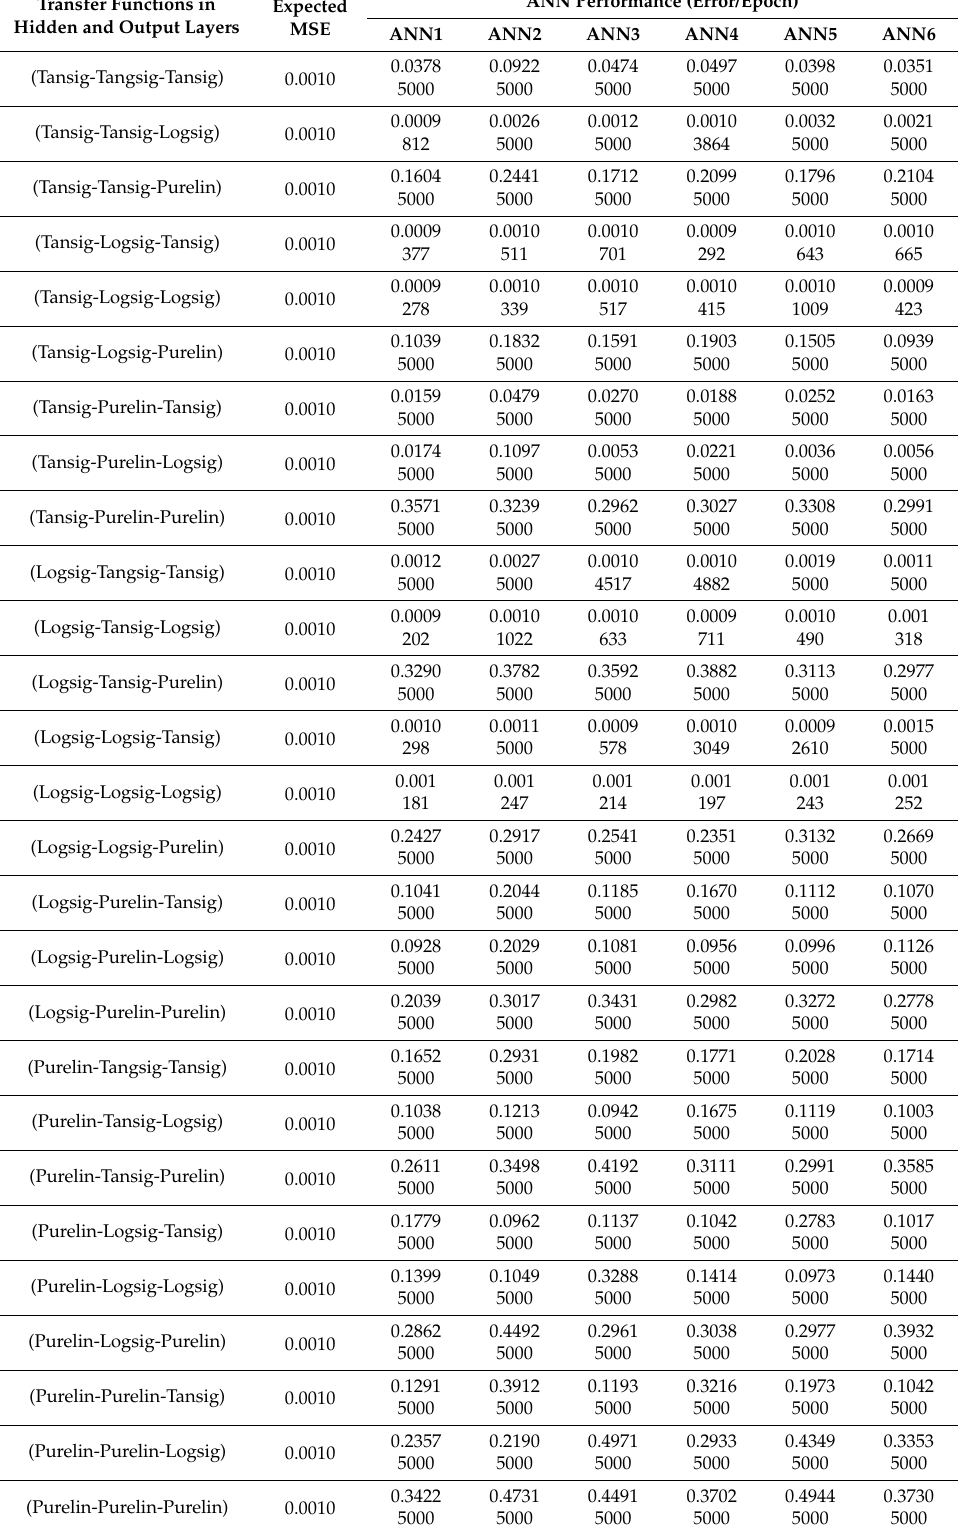
Table 4. Experiments for the transfer functions in hidden layers and output